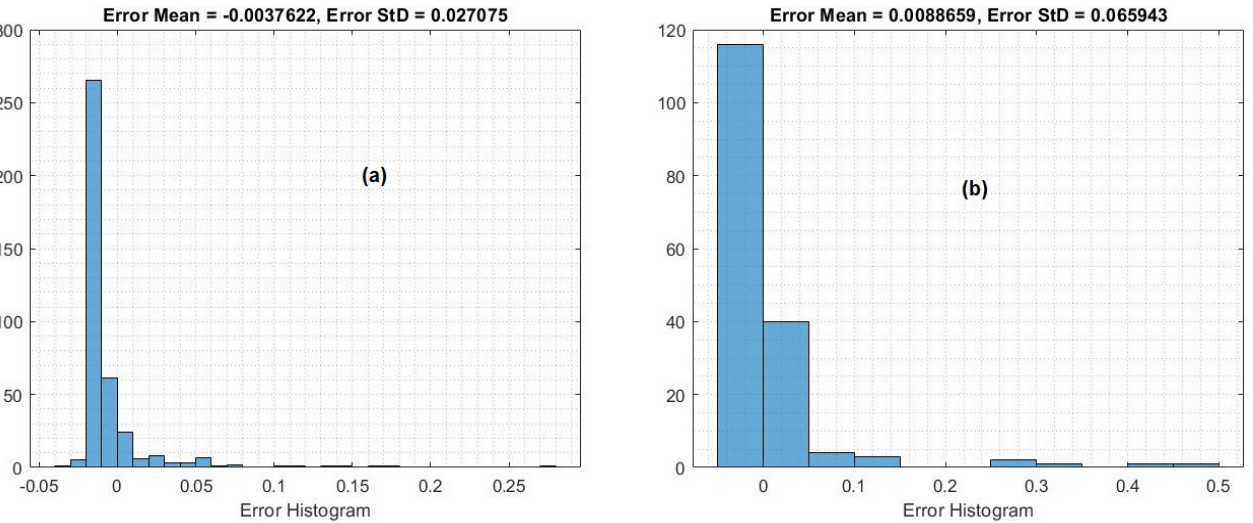
Figure 6. Error histograms of the LSTM model for predicting the price of the AMP cryptocurrency in ( a ) training and ( b ) testing.